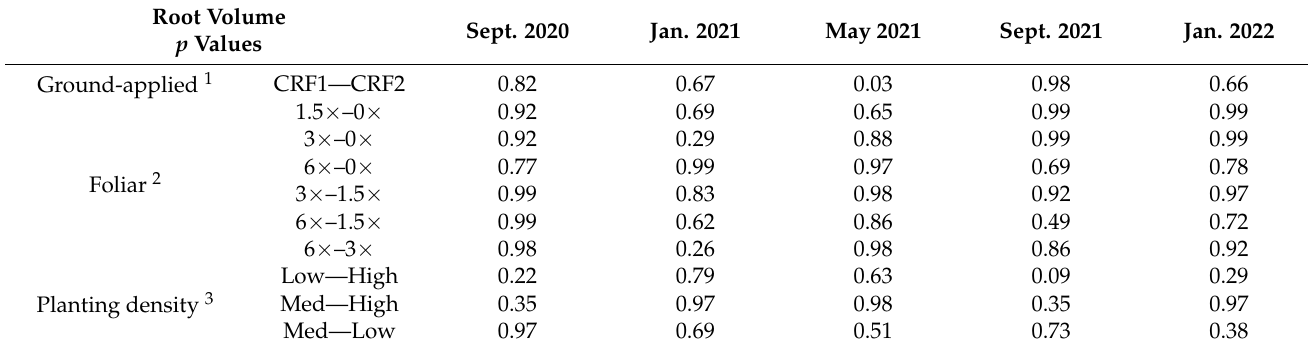
Table 7. p -values obtained via a three-way ANOVA followed by Tukey’s post hoc test, corresponding to the total root volume of ‘Ray Ruby’ grapefruit grafted on ‘Kuharske’ citrange planted in flatwood soils located in Fort Pierce, FL, USA, and treated with ground-applied fertilizer, foliar fertilizer and different planting densities from September 2020 to January 2022.